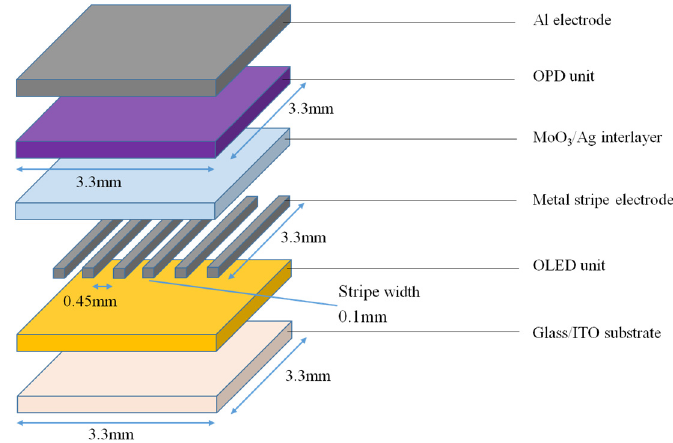
Figure 2. Schematic layout of the stripe-shaped front OLED components and the upper OPDs covered in regions between the stripes in the organic optical